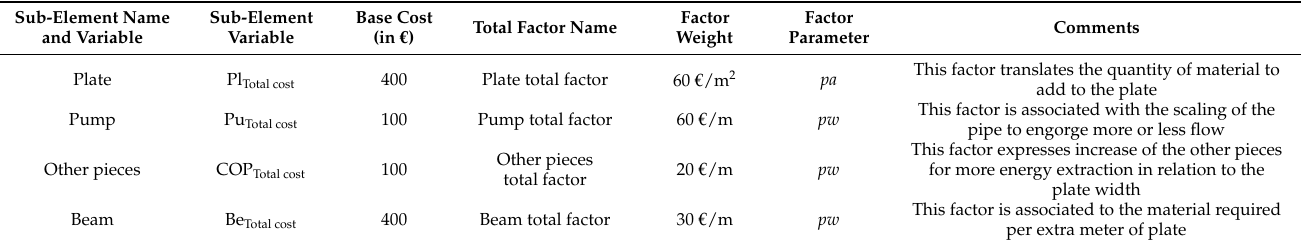
Table 4. Collector’s sub-elements’ base cost and